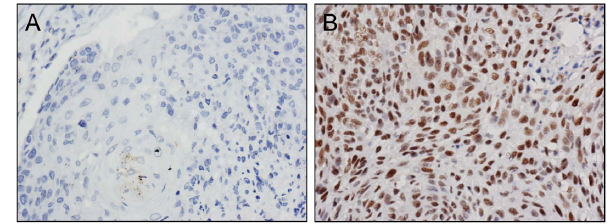
Figure 1. Representative immunohistochemical staining for ERCC1 in esophageal squamous cell carcinoma. Such staining was used for classification of nuclear staining intensity and assignment of a corresponding H-score used in further analyses in the study. A) ERCC1-negative esophageal squamous cell carcinoma tissue (H-score =0); B) High nuclear expression of ERCC1 in esophageal tumor cells with labeling intensity scored as 3 (H-score =3) (400 6 ).